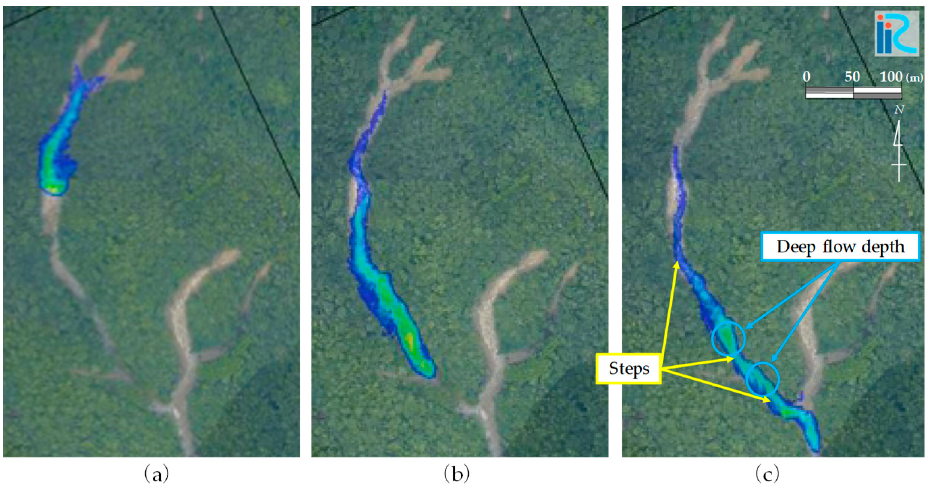
Figure 21. Temporal change of flow depth in the upstream of the main valley. ( a ), ( b ), and ( c ) show the flow depth at 18 s, 35 s, and 50 s, respectively.